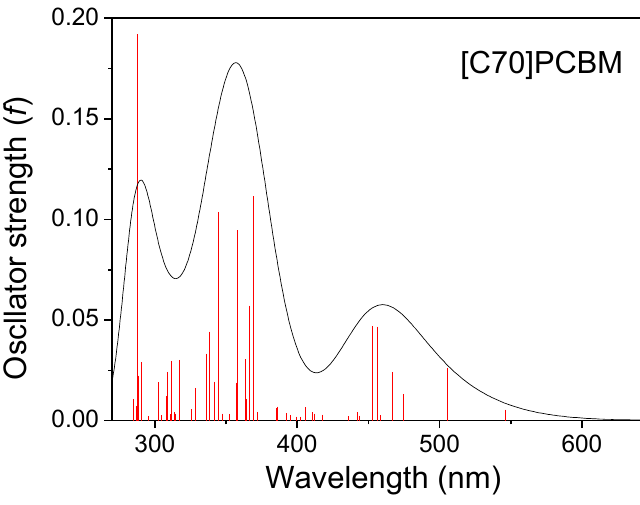
Figure 4. Absorption spectra of